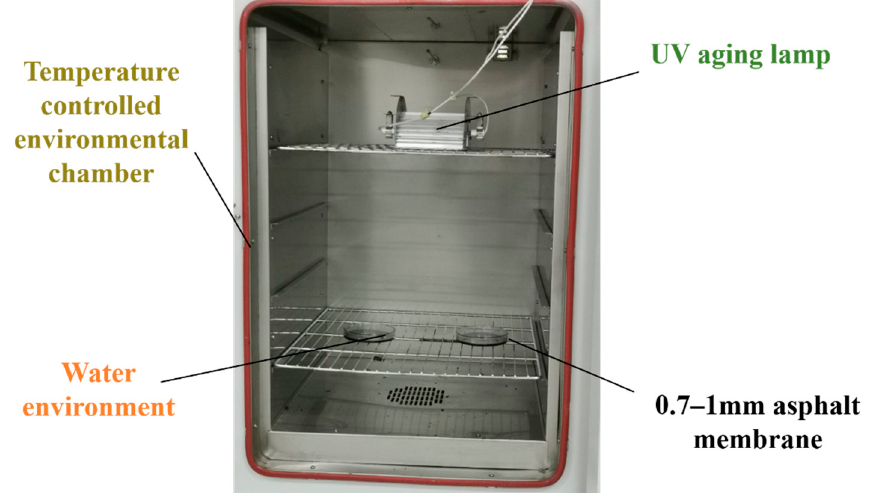
Figure 1. Complex aging simulation